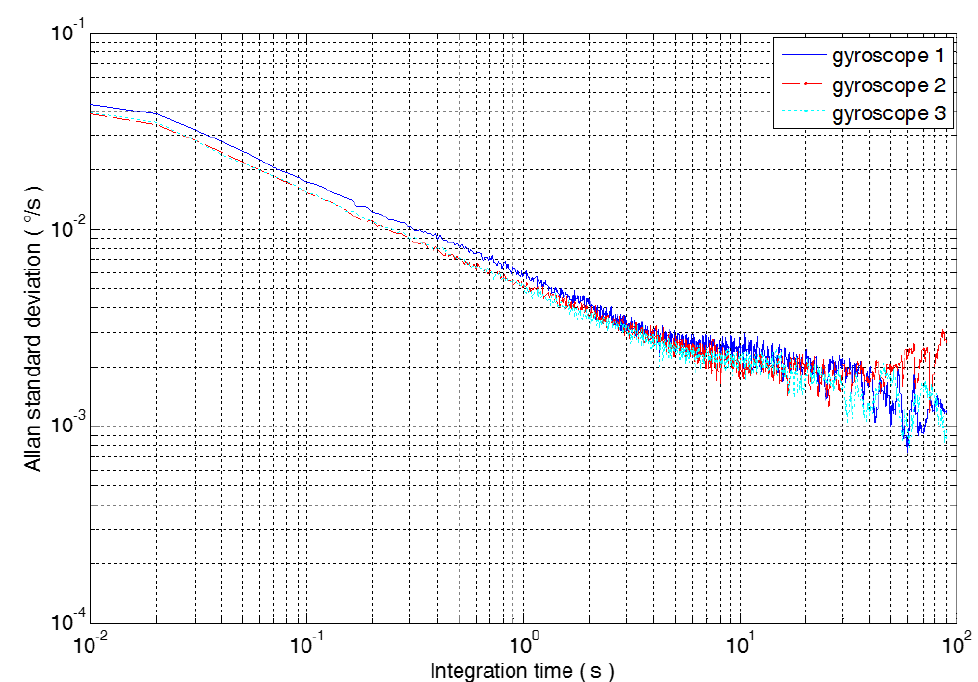
Figure 3. The Allan standard deviation curve of the three gyroscopes.